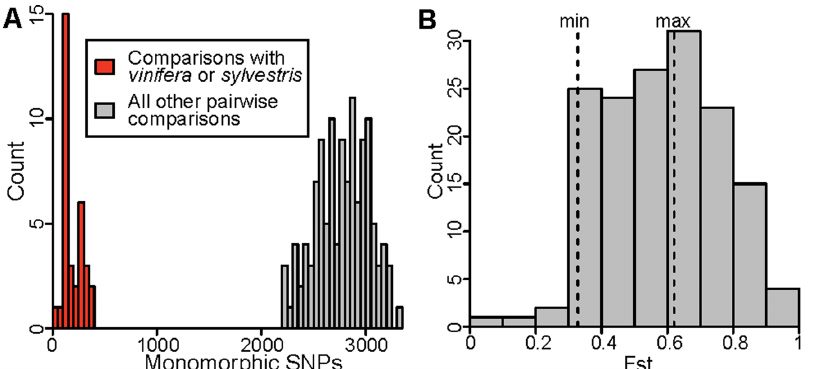
Figure 3. Evidence of ascertainment bias from the Vitis9KSNP array. A ) Between-species comparisons with vinifera or sylvestris involve far fewer monomorphic SNPs than other comparisons. The number of monomorphic SNPs was calculated for every pairwise comparison between species. Because vinifera and sylvestris show an excess of intermediate frequency alleles compared to other Vitis species using the Vitis9KSNP array, comparisons involving vinifera or sylvestris display fewer monomorphic sites relative to comparisons involving other species pairs. B ) The dotted lines indicated by ‘‘min’’ and ‘‘max’’ are the minimum and maximum F ST values from comparisons between vinifera or sylvestris and other species. The ascertainment bias results in intermediate F ST estimates with relatively little variation for pairwise comparisons between species involving vinifera or sylvestris .